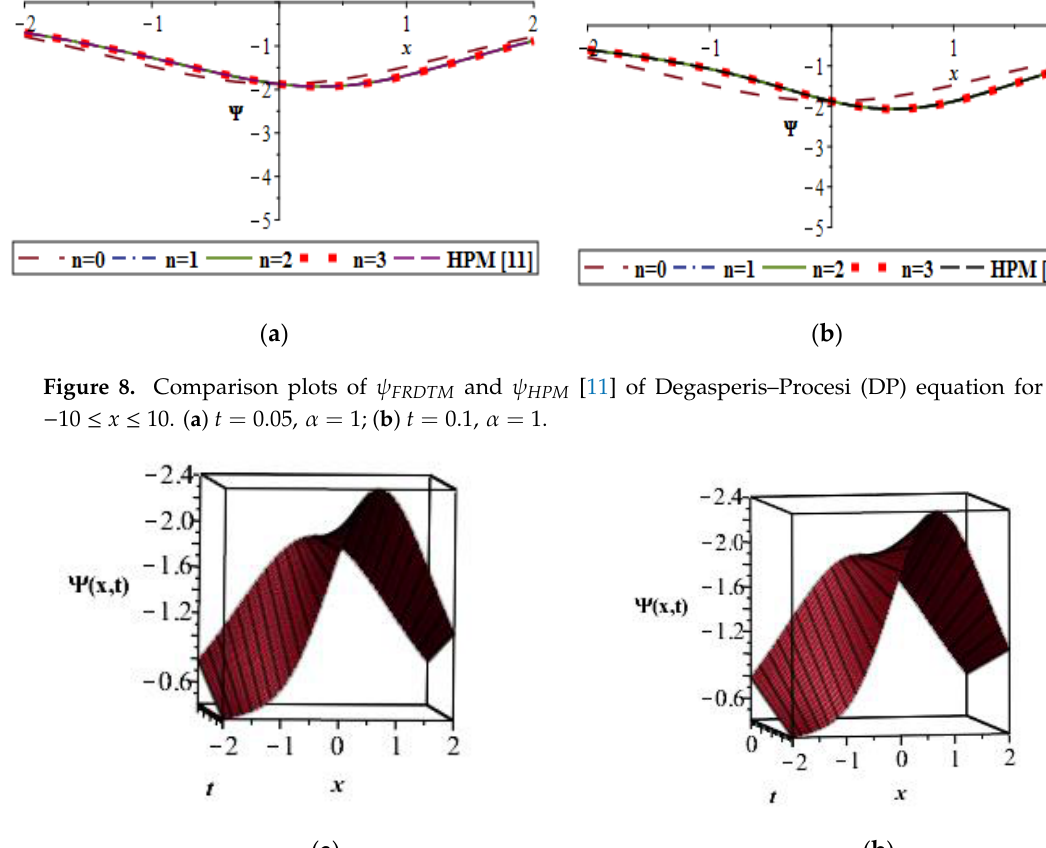
Figure 7. The solution plots of mCH equation at α = 1 ( a ) two-terms FRDTM solution ( b ) HPM solution [11]. Table 3. The two term FRDTM approximation results of mCH equation with HPM [11] for 1 = .